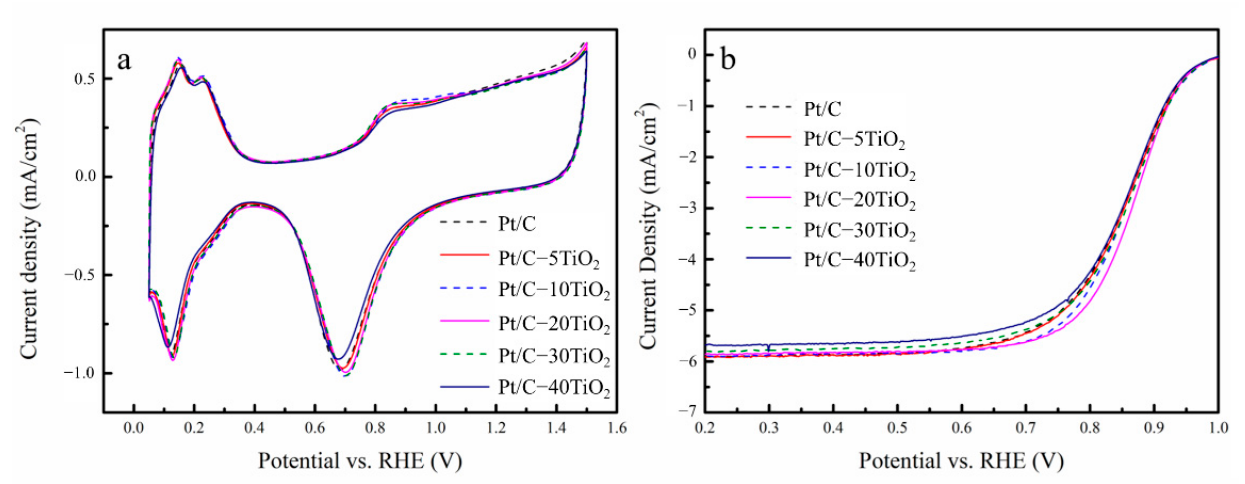
Figure 3. The ( a ) CV and ( b ) LSV curves of all pristine catalysts (before poisoning). Table 1. Electrochemical data of all pristine (before poisoning) and SO 2 -poisoned catalysts. Pristine SO 2 Poisoned Negative Shift of E 1 / 2 after Sample